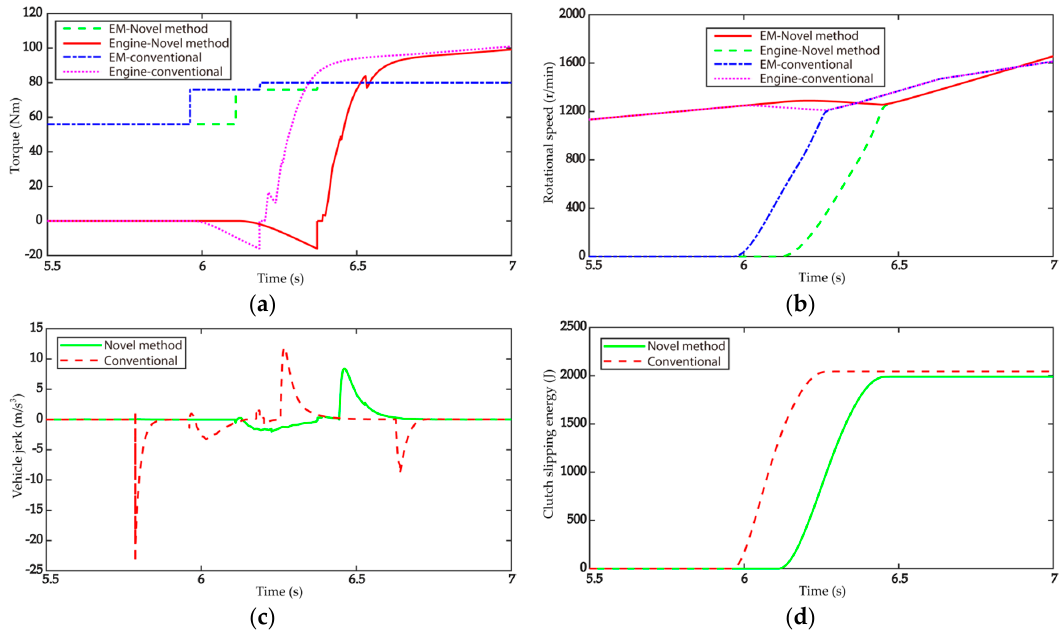
Figure 9. Comparison result in simulation. ( a ) Engine and EM torque, ( b ) engine and EM speed, ( c ) vehicle jerk , ( d ) clutch slipping energy loss.